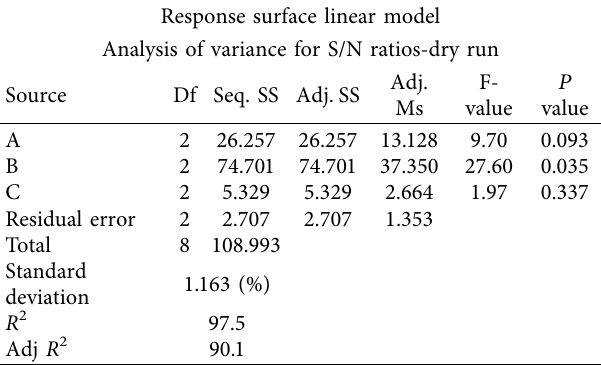
Table 5: ANOVA for S/N ratios (R